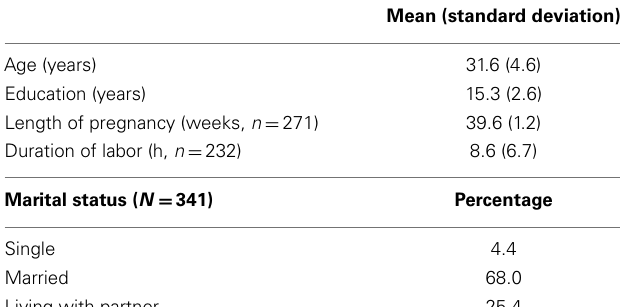
Table 1 | Descriptive statistics of the participants